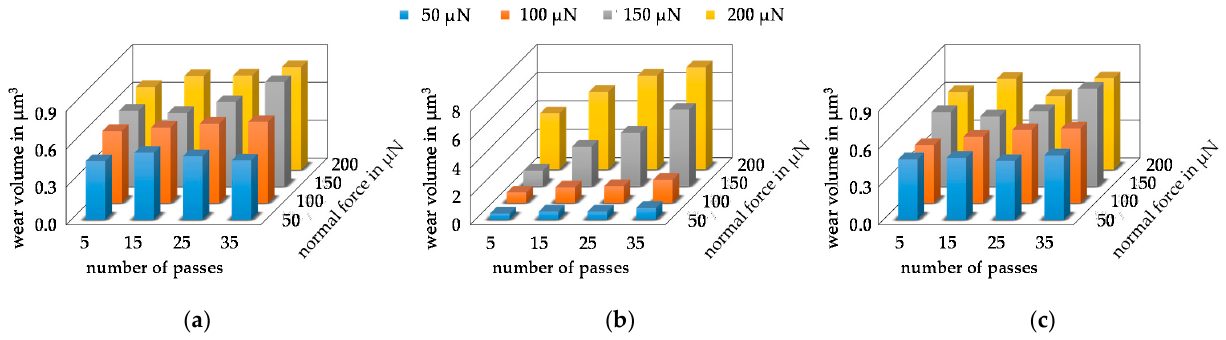
Figure 12. Average values determined of the wear volume of the respective parameter combination as ( a ) volume determination via subtraction of post ‐ scan and pre ‐ scan of Mo ‐ coating. ( b ) Volume determination via subtraction of post ‐ scan and pre ‐ scan of MoO 3 ‐ coating. ( c ) Volume determination via post ‐ scan of Mo ‐ coating only.